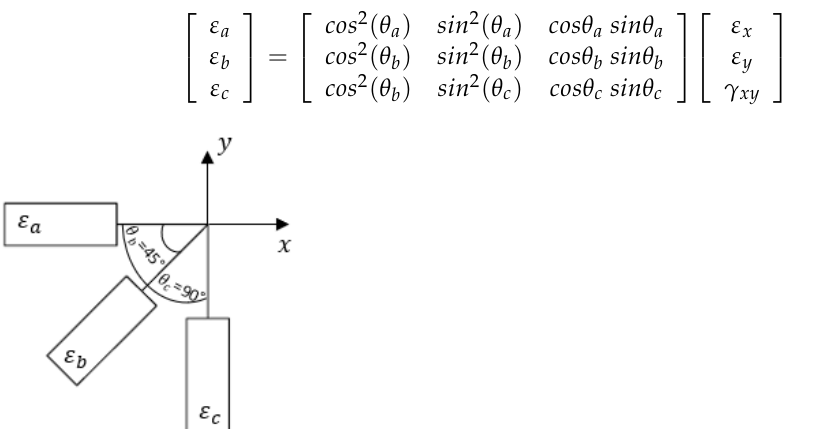
Figure 13. Illustration of the triaxial strain rosette used in this study.